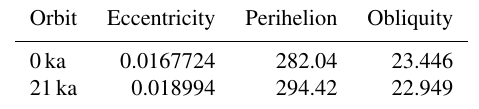
Table 2. Orbital parameters for present day (0ka) and LGM (21ka).